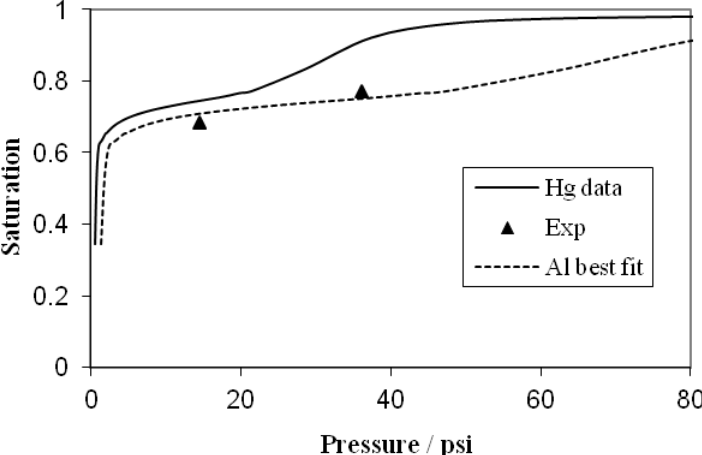
Figure 13. Experimentally-determined saturation values from foam densities, saturation vs . pressure curves for Hg (solid line) and for Al (determined by fitting to the experimental data—dashed line) for preforms compacted at 32 MPa.